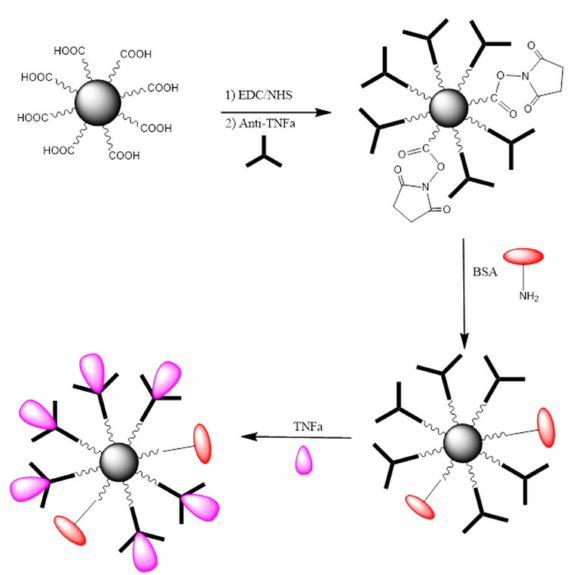
Figure 5. MNPs@SiO 2 -NH 2 -COOH bio-functionalization with anti-TNF- α -antibody. Red: BSA Purple: TNF- α .